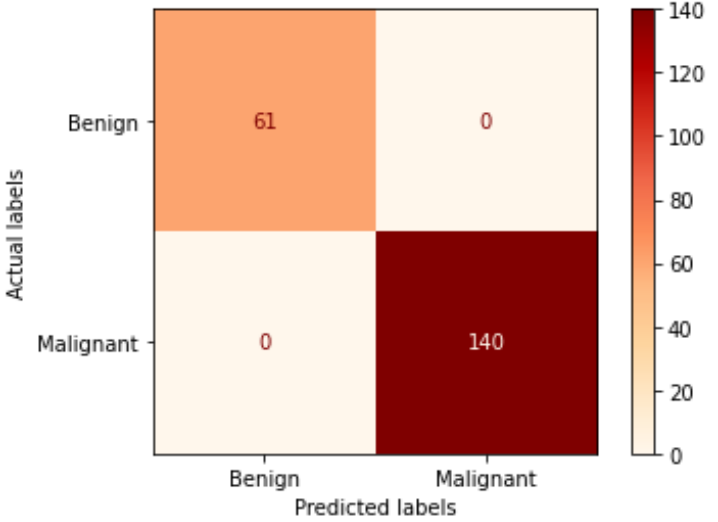
Figure 18. Confusion matrix of Xception model in 200 × magnification-dependent binary classification.